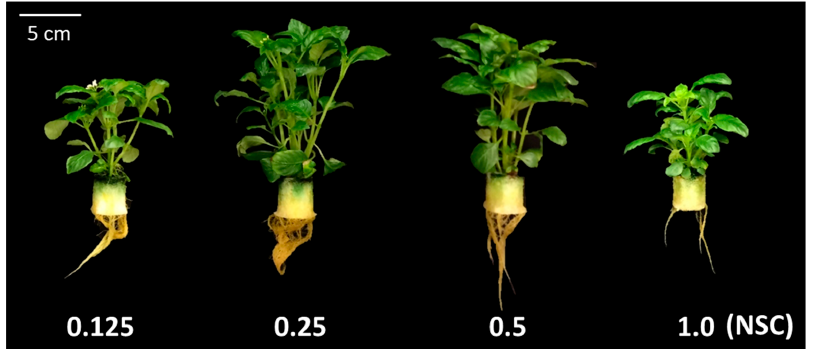
Figure 2. Pictures of O. pumila grown in each nutrient solution concentration (NSC) at 63 days after the start of the treatment (DAT) in experiment 1. The treatments were 0.125, 0.25, 0.5, and 1.0 NSC. The 1.0 NSC was the standard concentration of Otsuka-A nutrient